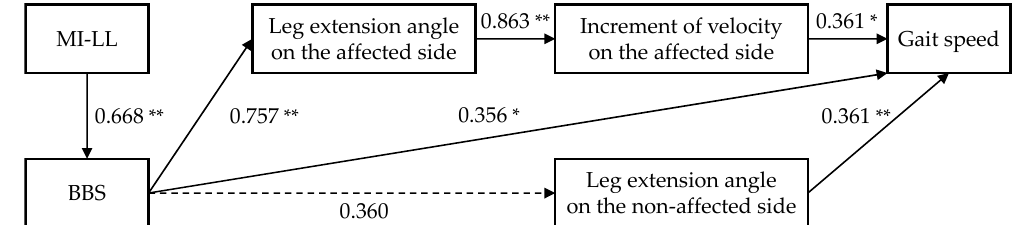
Figure 2. Path analysis for the effect of the Berg balance scale (BBS) and leg extension angle on gait speed. Numbers represent standardized coefficient values ( β ). Continuous arrows represent the statistically significant paths ( p < 0.05), and dashed arrows represent non-significant paths. * p < 0.05, ** p < 0.01.